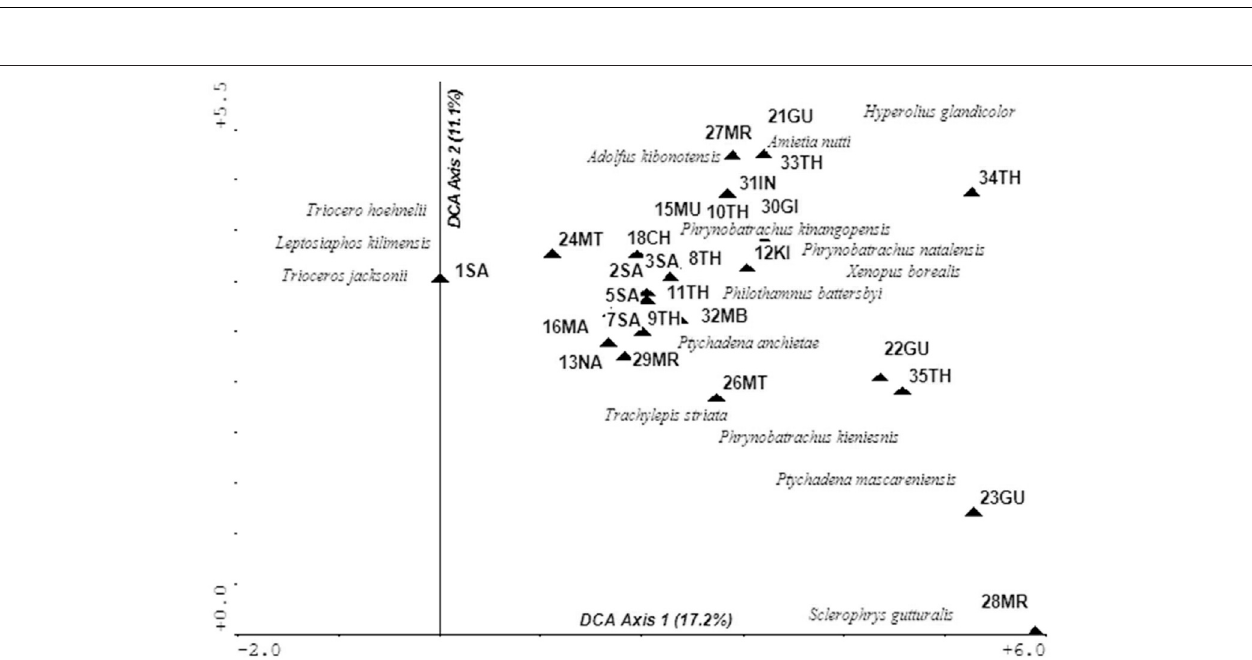
FIGURE 7 | DCA biplot of herpertofauna of the Upper Tana River watershed.